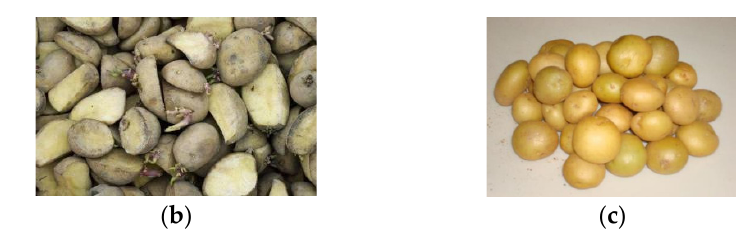
Figure 2. Types of potato: ( a ) whole tuber; ( b ) sliced tuber; ( c ) mini-tuber.